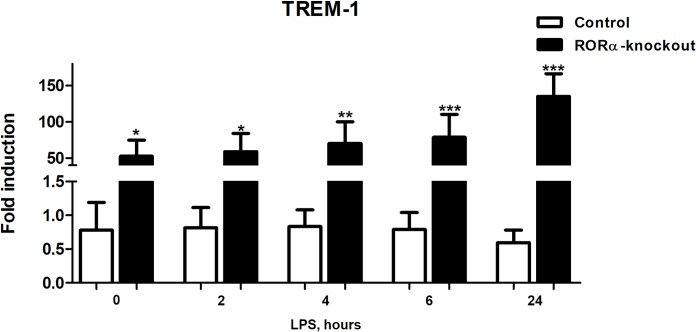
Cells lacking RORA have elevated levels of TREM1 mRNA.TREM1 was expressed at significantly higher levels in untreated RORA-deletion cells when compared to THP-1 sgRenilla control cells. TREM1 expression was not significantly affected by treatment with LPS. 2.5×105 cells in 24-well plates were differentiated using 50 ng/ml PMA for 48 hours. After 24 hours of rest in PMA-free media, TREM1 expression level was determined using qRT-PCR for RNAs isolated from cell lysates. Statistical significance was calculated using ANOVA test. Stars indicate significance of differences between control and knockout cells.